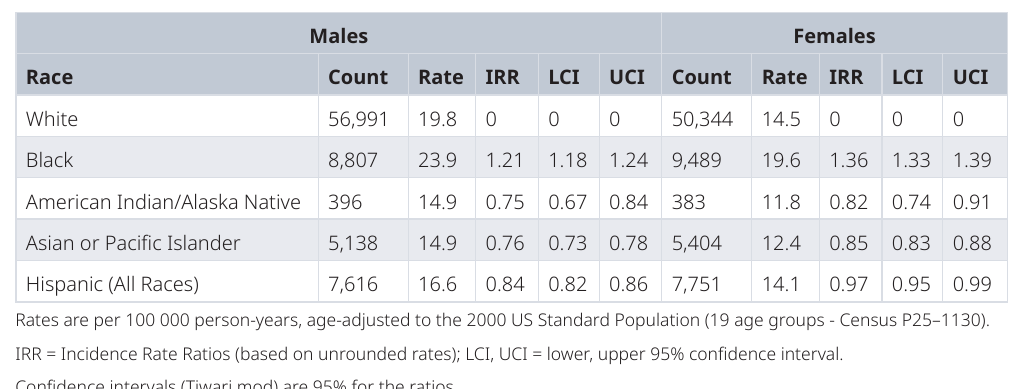
Table 4. Total cases, rates, and male to female incidence rate ratios by gender and racial/ethnic group,